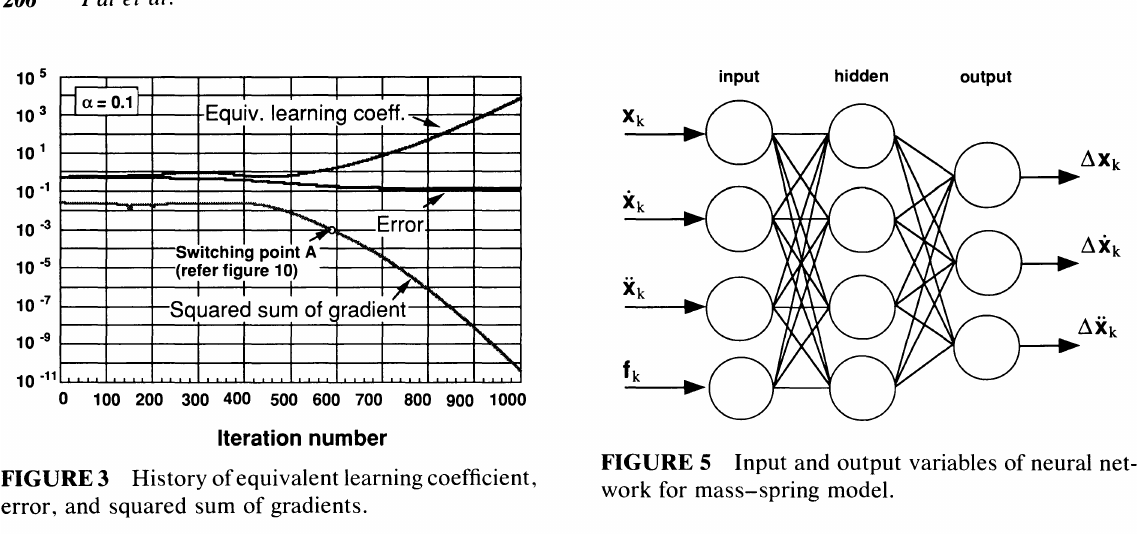
FIGURE 3 History of equivalent learning coefficient, error, and squared sum of gradients.